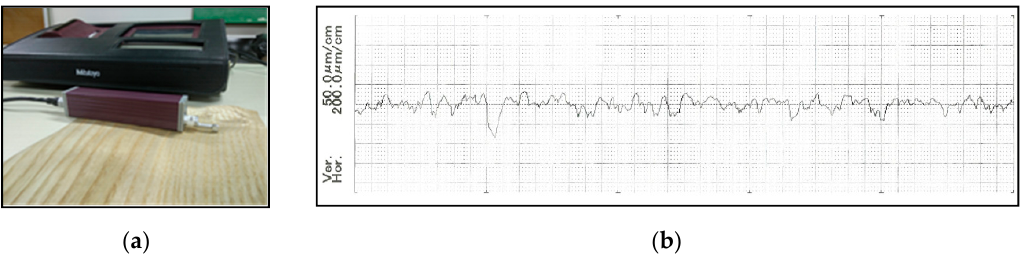
Figure 4. Roughness test using the Mitutoyo Surftest SJ-301 profilometer ( a ); an example of the roughness spectrum on a poplar sliced veneer sheet of typical structure ( b ).